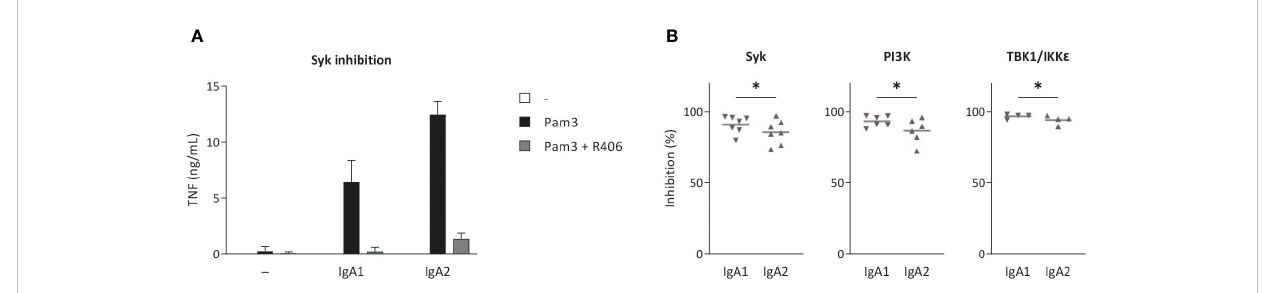
FIGURE 4 IgA-induced cytokine production can be abolished by small molecule inhibitors targeting downstream signaling molecules for Fc a RI. Cytokine production by CD103 + DCs (40,000 cells/well) upon co-stimulation with Pam3CSK4 and IgA1 or IgA2 after treatment with small molecule inhibitors R406 (A, B) , alpelisib, or BX795 (B) speci fi c for Syk, PI3K and TBK1/IKK ϵ , respectively, was measured by ELISA. TNF production of cells pre-treated with inhibitors was normalized to that of DMSO controls. Data of a representative example measured in triplicate (mean + SD) (A) or multiple donors (B) . *p <